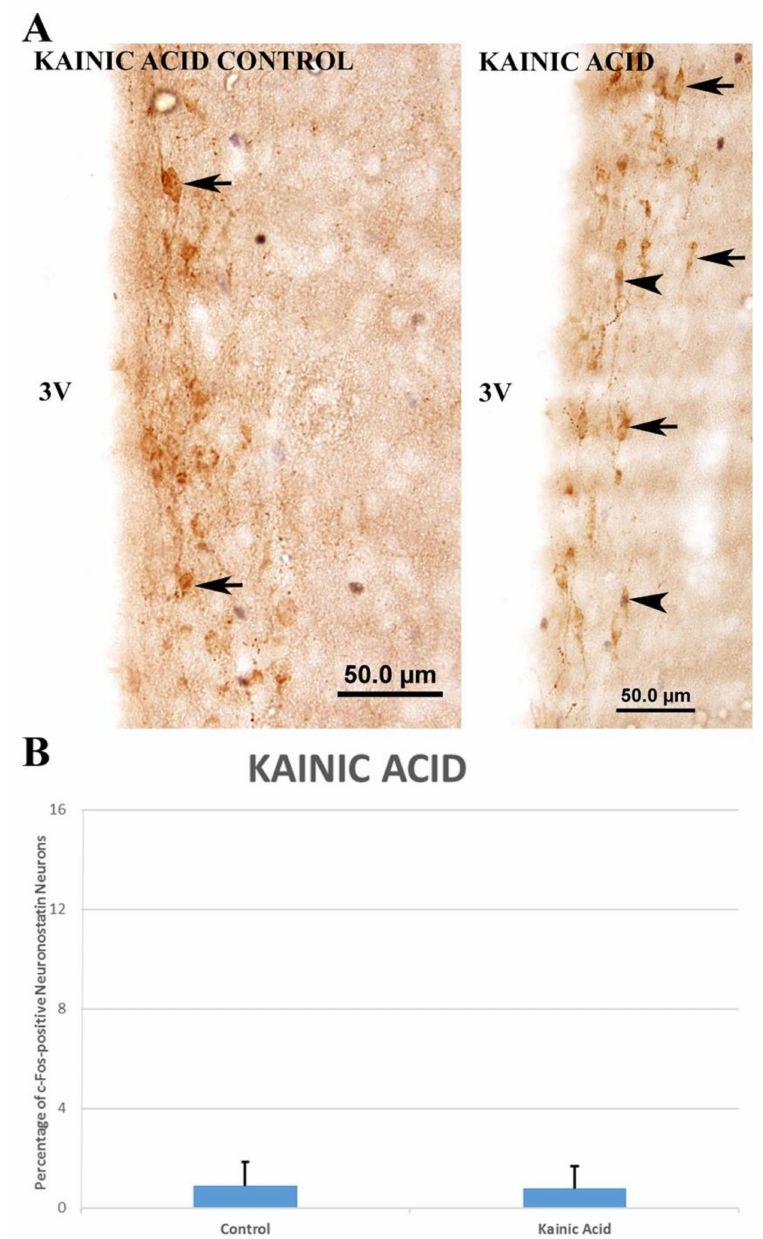
Figure 4. E ff ect of kainic acid administration on c-Fos expression in neuronostatin neurons located in the anterior hypothalamic periventricular nucleus ( A ). c-Fos protein-expressing neuronostatin neurons ( (cid:78) ) and c-Fos-negative neuronostatin neurons (